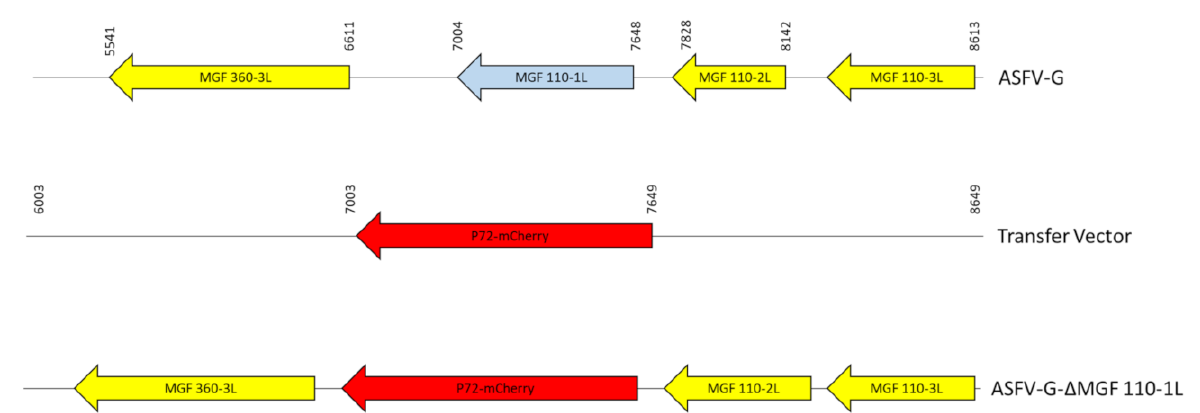
Figure 3. Schematic for the development of ASFV-G- ∆ MGF110-1L. The transfer vector contains the p72 promoter and a mCherry cassette; the flanking left and right arms are indicated, and were designed to have flanking ends to both sides of the deletion/insertion cassette. The resulting ASFV-G- ∆ MGF110-1L virus with the cassette inserted is shown on the